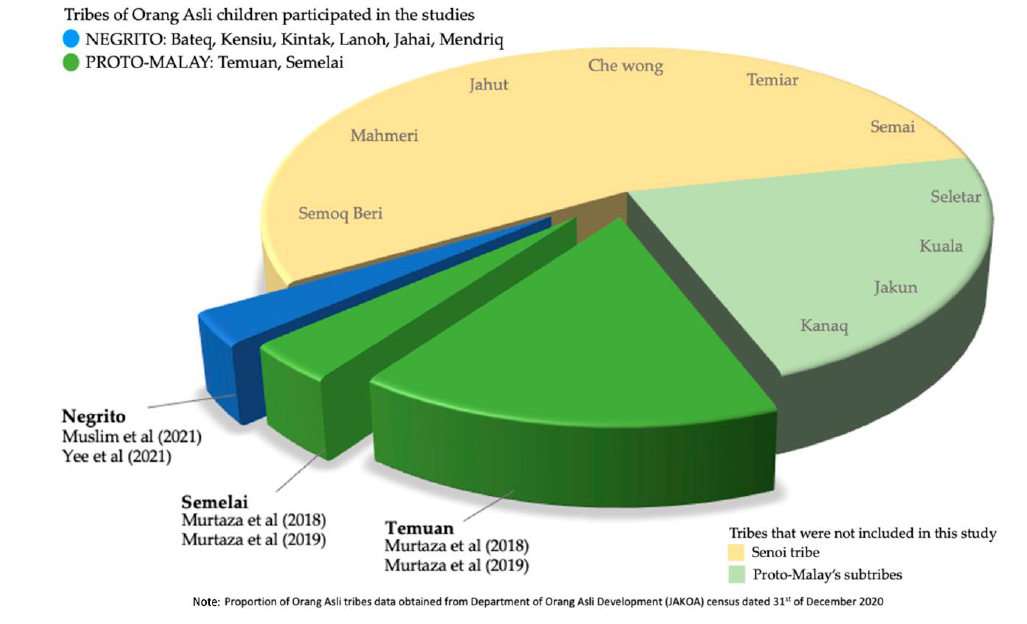
Figure 3. Tribes of Orang Asli children participated in the studies [25,27 – 29]. Table 1. Overall characteristics of included studies on anaemia among OA children in Malaysia,